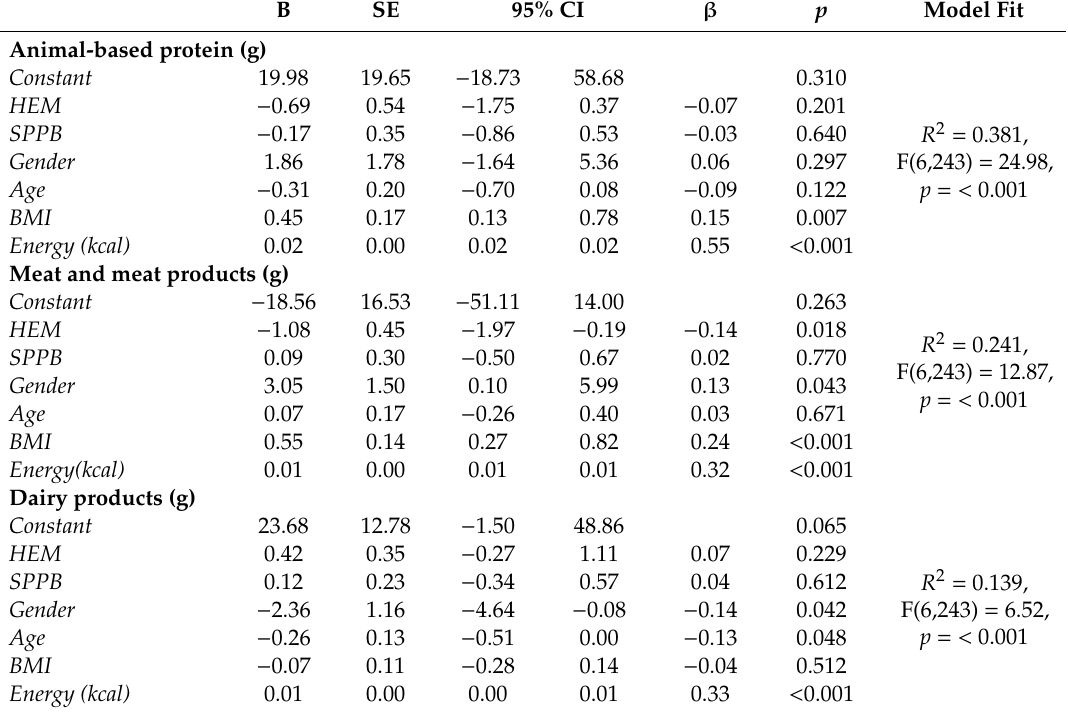
Table 4. Results of the final step of the hierarchical multiple regression analysis testing the association of HEM and protein intake by animal and plant sources ( N =